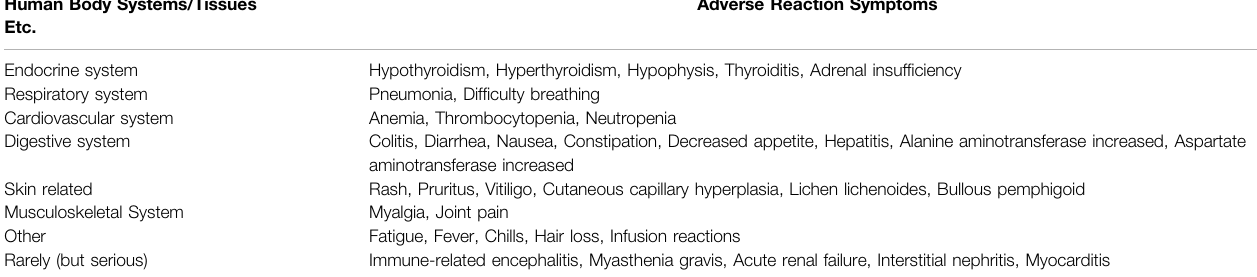
TABLE 4 | Major adverse events in PD-1/PD-L1 immunotherapy. Human Body Systems/Tissues